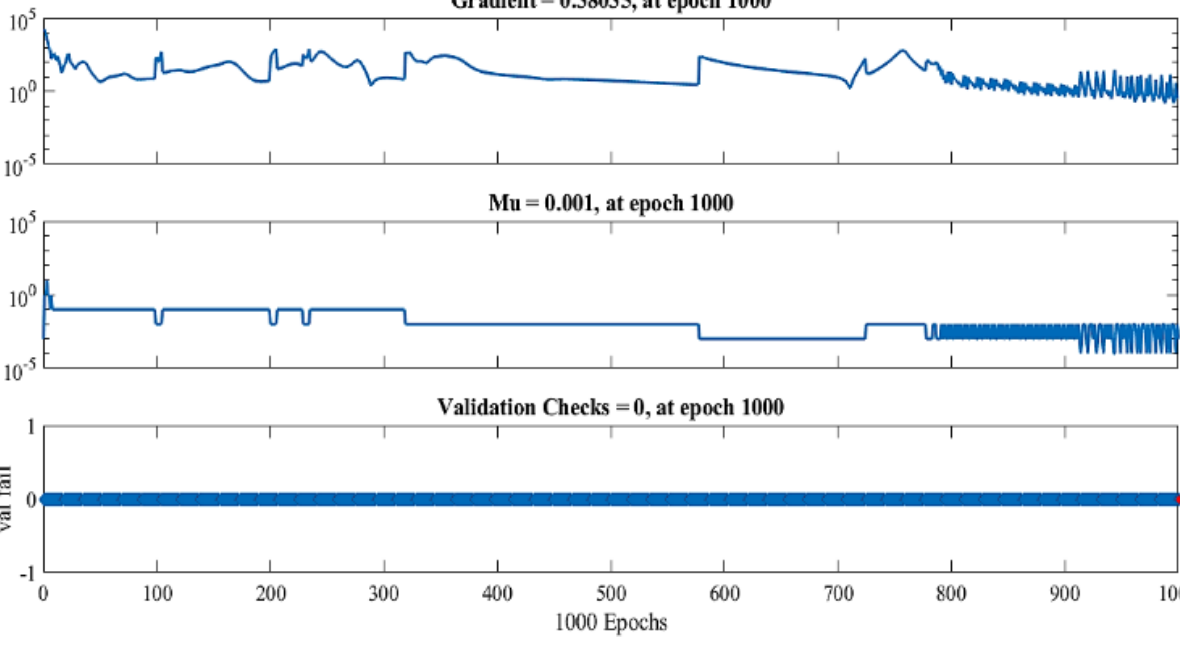
Figure 8. Data training evaluation and validation using HNN Figures 8 and 9 present the data training evaluation and Ethiopian power system. It can be seen that the demand validation, the time-series response of training the create and supply are affected by the intermittency and network with renewable penetration effects to the variability of